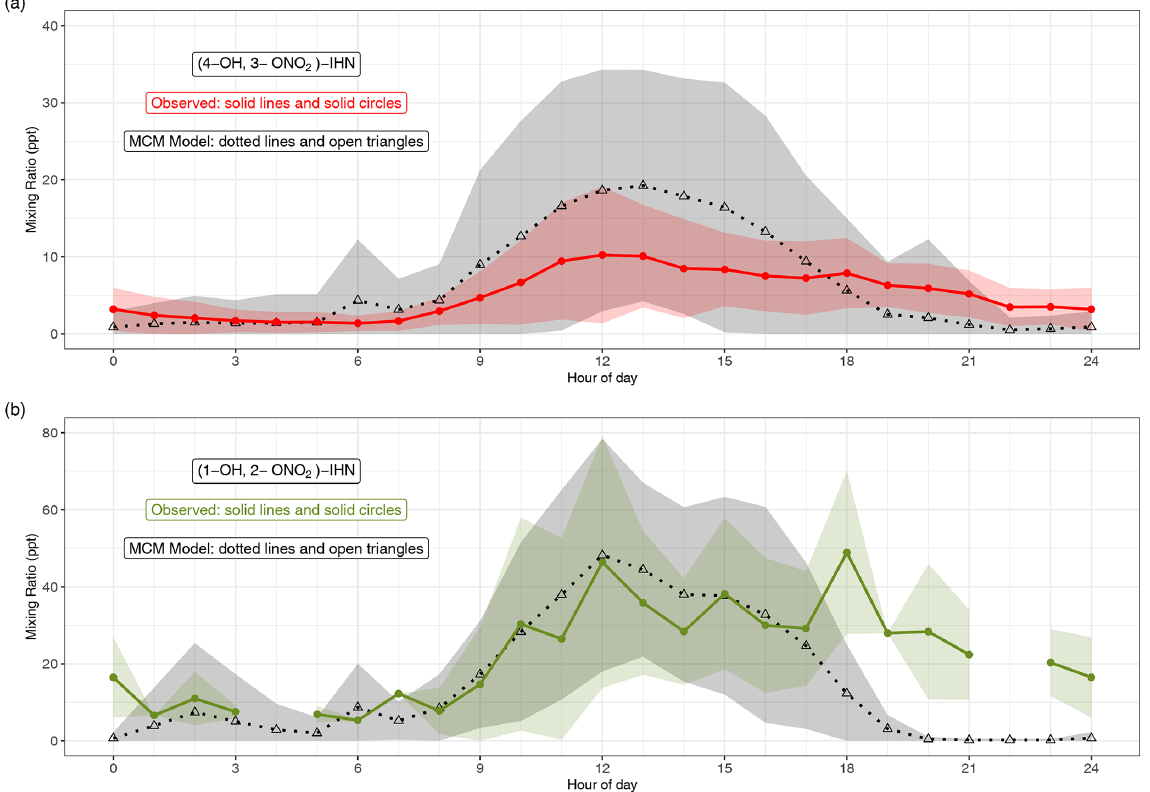
Figure 2. Modelled and observed mixing ratios of (a) (4-OH, 3-ONO 2 )-IHN and (b) (1-OH, 2-ONO 2 )-IHN. Data points are the mean, and the shaded areas represent ± 1 SD in the variability of values for each hour of the